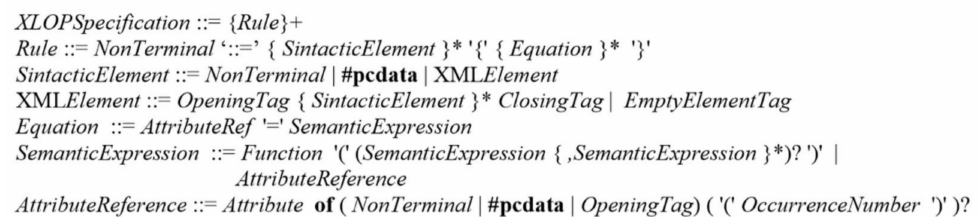
Figure 1. Extensible markup language (XML) language-oriented processing (XLOP) specification language